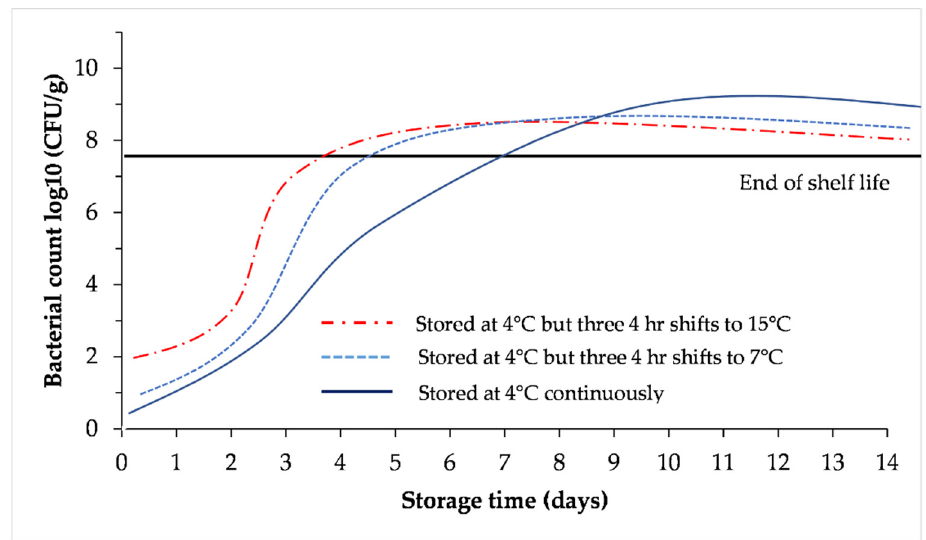
Figure 7. Growth of Pseudomonas spp. fitted with the Gompertz model on poultry during complete storage. Redrawn from Bruckner et al. [50].